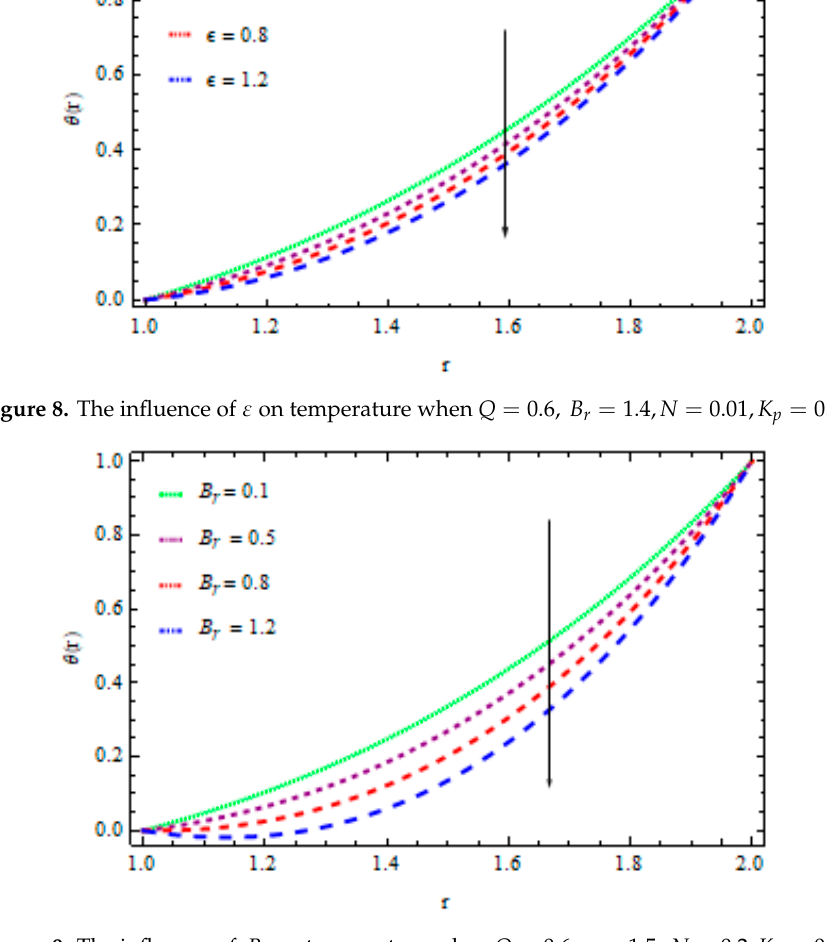
Figure 9. The influence of